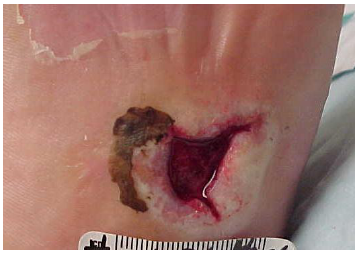
Figure 7. Appearance of wound at week eight, prior to application of bi-layered living skin equivalent.